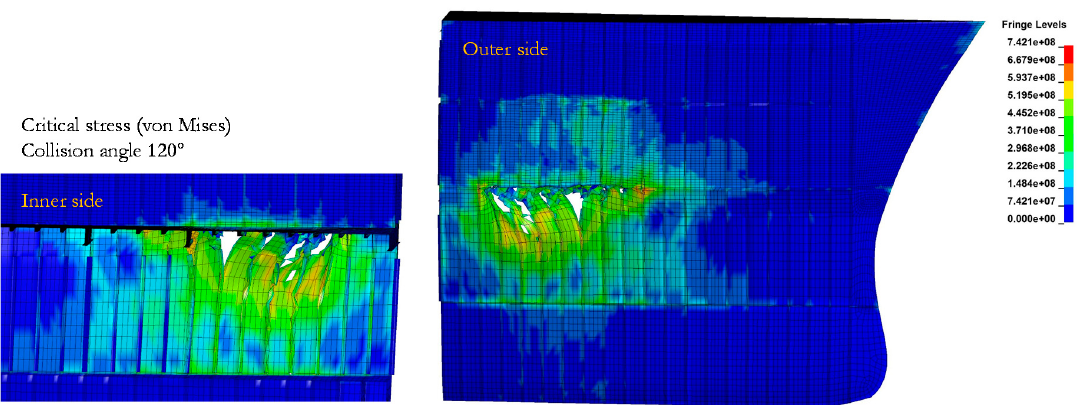
Figure 15. Critical stress (von Mises formulation) of the collision angle 120°.